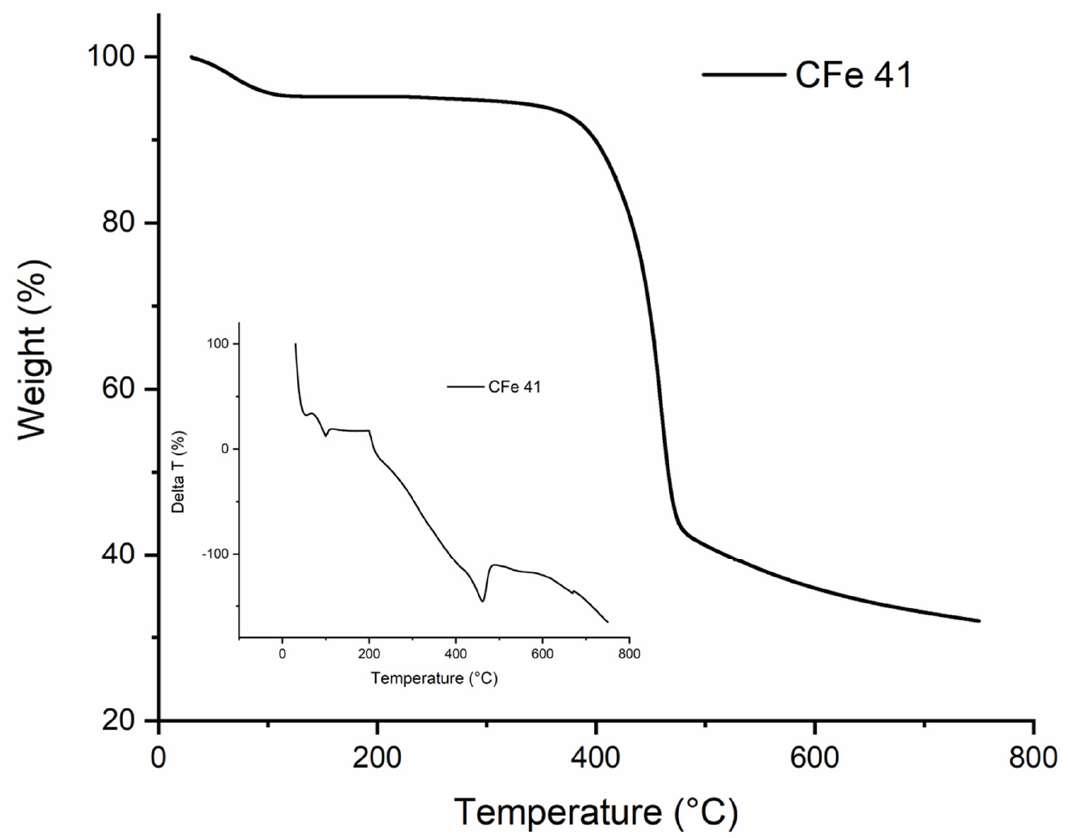
Figure 2. TG and DTA curves of the CFe 41 sample in N 2 atmosphere.